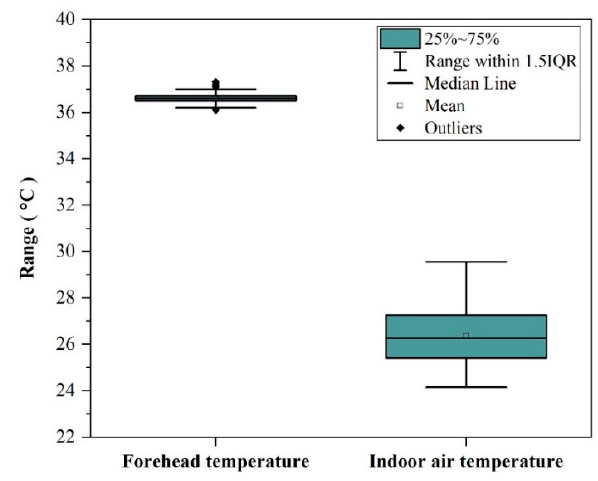
Figure 7. Forehead temperature and indoor air temperature measurements.